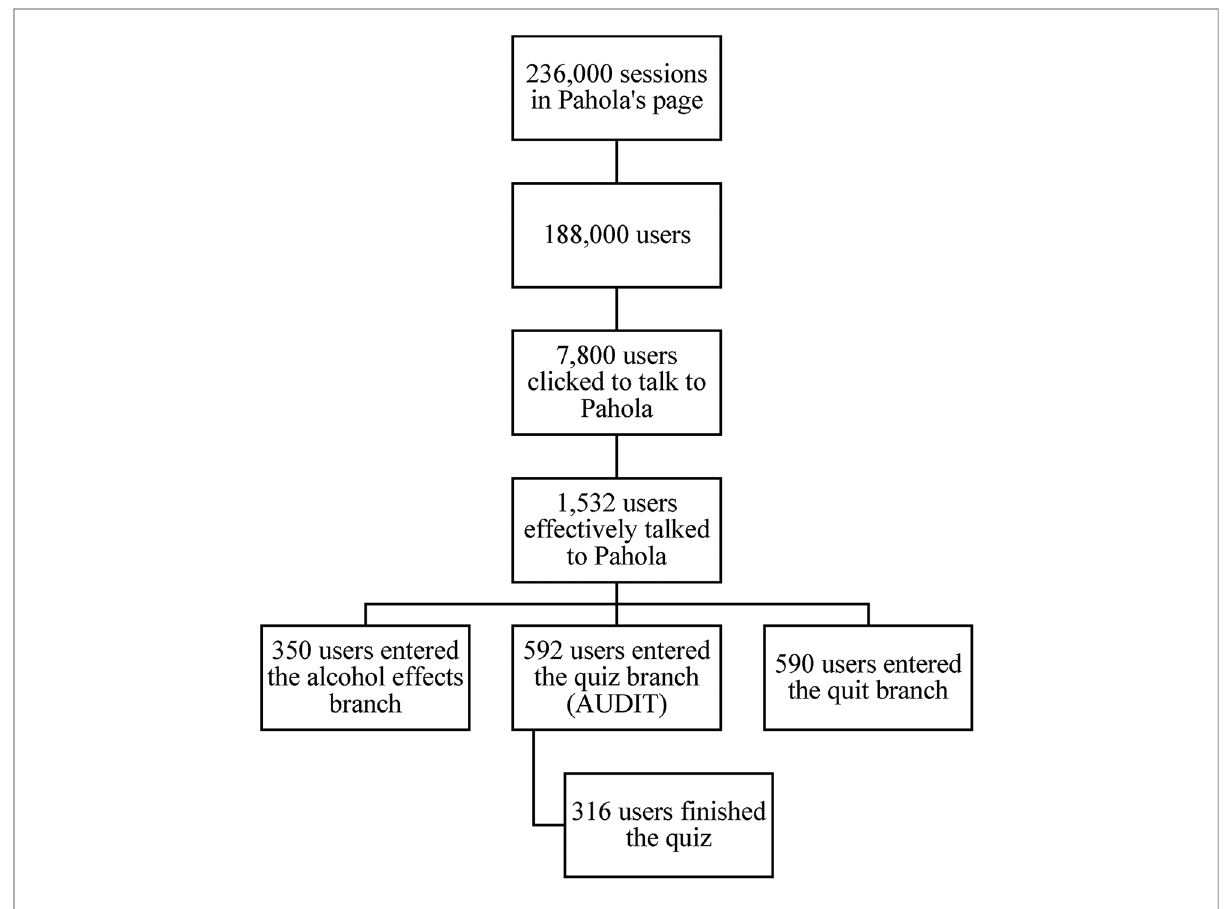
FIGURE 2 How users accessed Pahola — from November 19, 2021 to January 16,